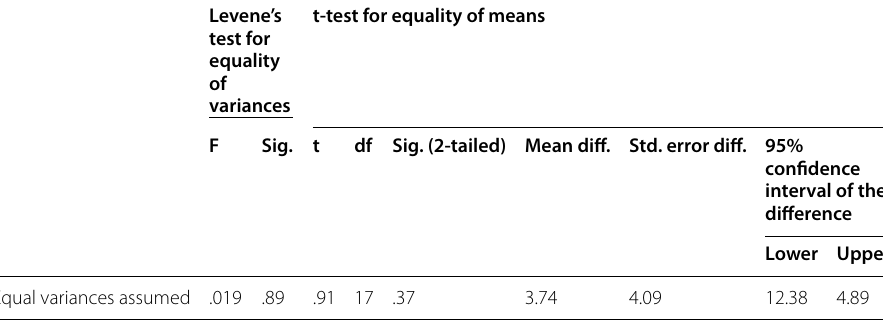
Equal variances assumed .019 .89